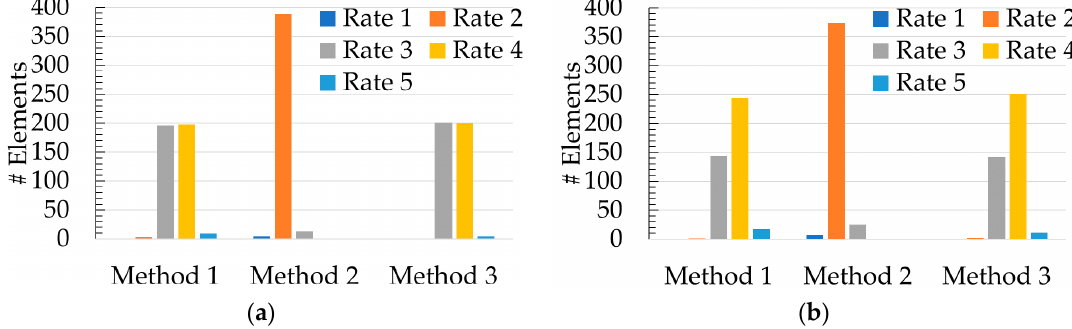
Figure 10. The number of elements per Reliability Rate over a month, being ( a ) DR event 1; ( b ) DR event 2.